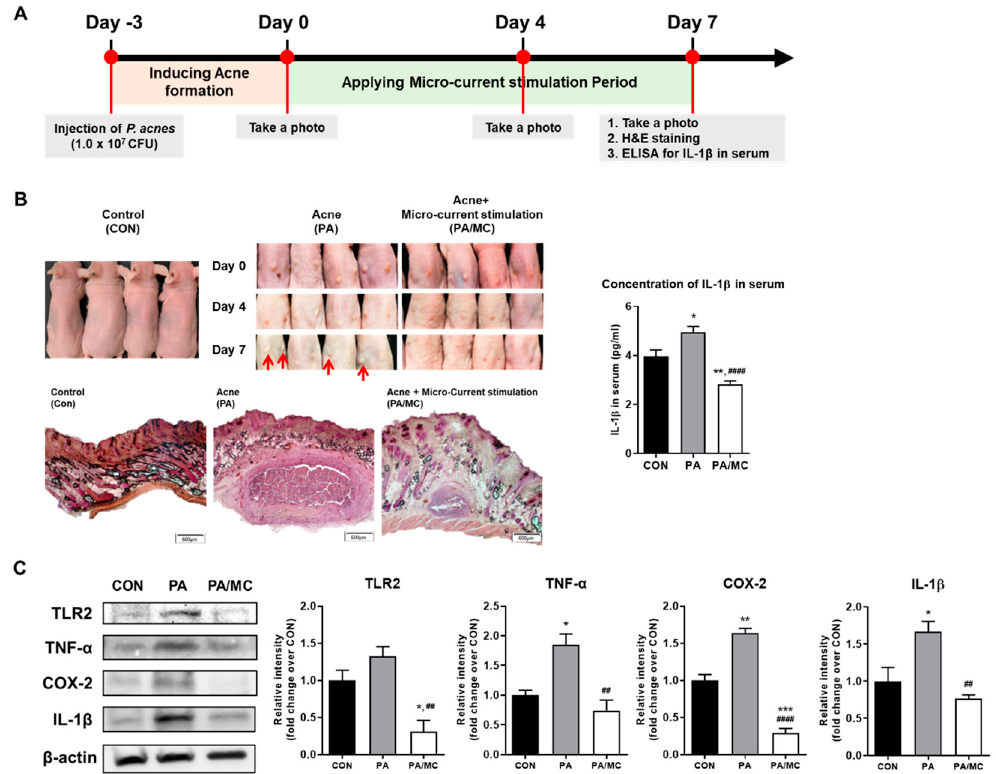
Figure 3. ( A ) Schematic diagram indicating the timeline for animal experiments. ( B ) Photographs of dorsal skin were taken at days zero, four, and seven in control (CON), P. acnes -injected mice (PA) used as a positive control, and P. acnes -injected mice applied MC with the intensity of 50 µ A group (PA/MC). Longitudinal sections of the individual lesions for each group by H&E staining on day seven. Also, ELISA analysis was conducted to measure serum IL-1 β contributing to the development of inflammatory papules, pustules, and nodules in acne. ( C ) Immunoblot analysis of TLR2 and pro-inflammatory cytokines or mediators on the tissue of acne lesions. The tissue lysate was analyzed by immunoblot using TLR2, TNF- α , COX-2, and IL-1 β antibodies. * p < 0.05, ** p < 0.01, *** p < 0.001, vs. control group. ## p < 0.01, #### p < 0.0001 vs. positive control.